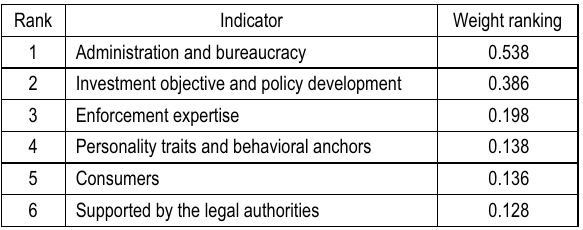
Table 4. Ranking of each indicator and their impact on the implementation of policy Weight